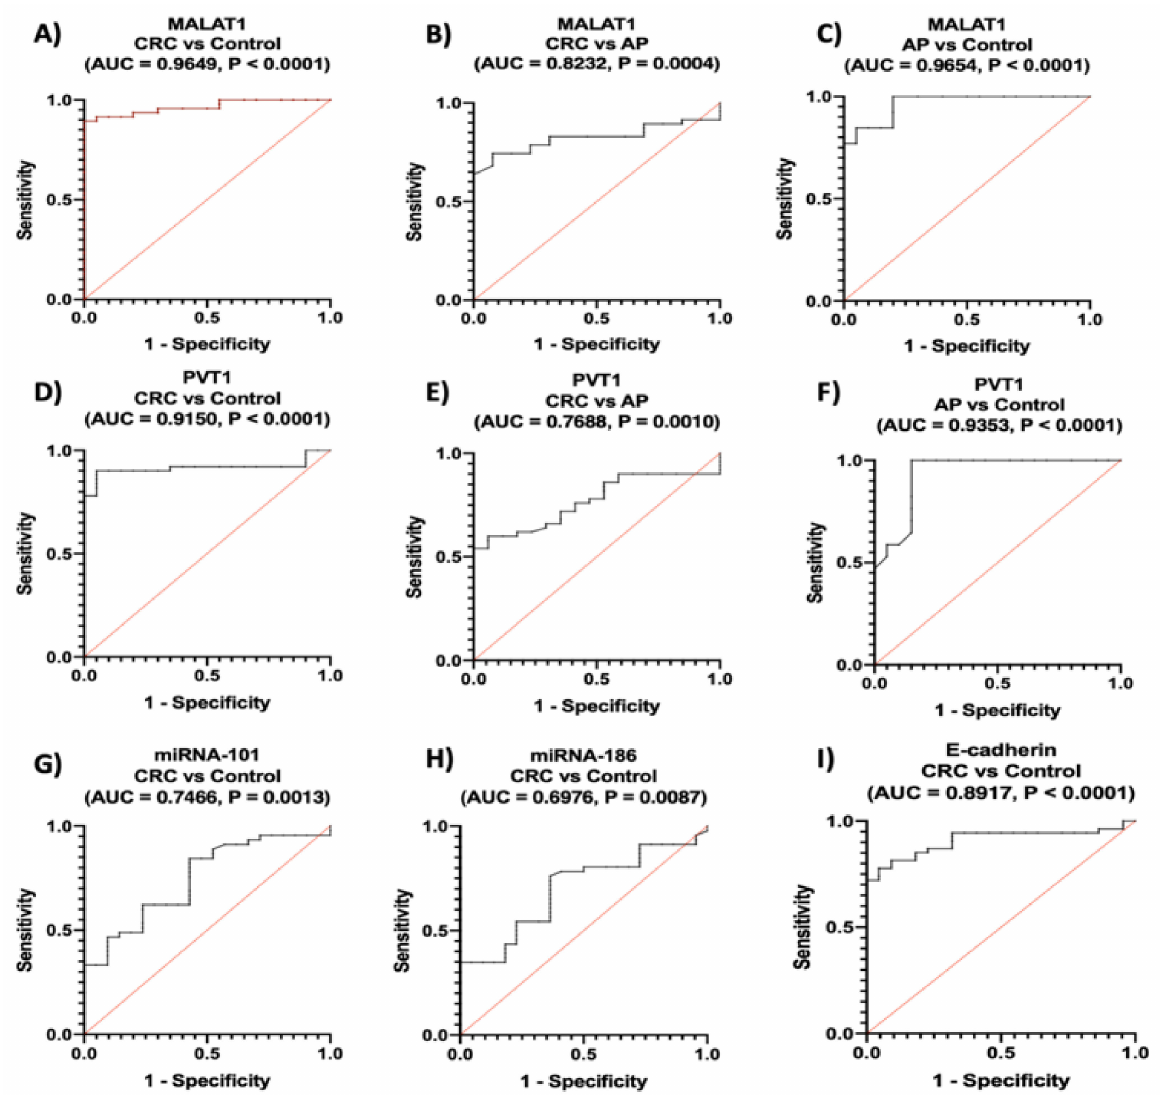
Figure 4. Diagnostic performance of serum ( A – C ) MALAT1 , ( D – F ) PVT1 , ( G ) miRNA-101 , ( H ) miRNA-186 and ( I ) E-cadherin. Using ROC curve analysis, CRC ( n = 140), AP ( n = 40), healthy controls ( n =